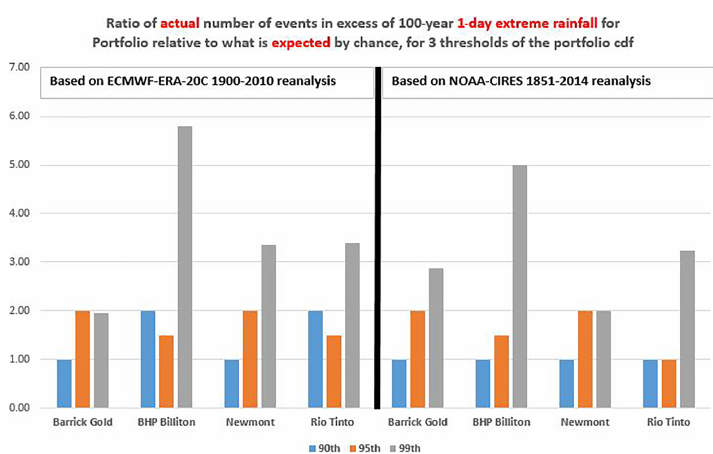
Figure C3. Ratio of the actual number of the number of 10-year, 10-day extreme rainfall events fitting the four portfolio relative to what is expected by chance, for three thresholds of the portfolio cdf.